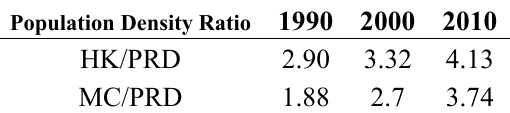
Table 7. The population density ratio (PRD) of Hong Kong (HK) and Macau (MC) vs. the